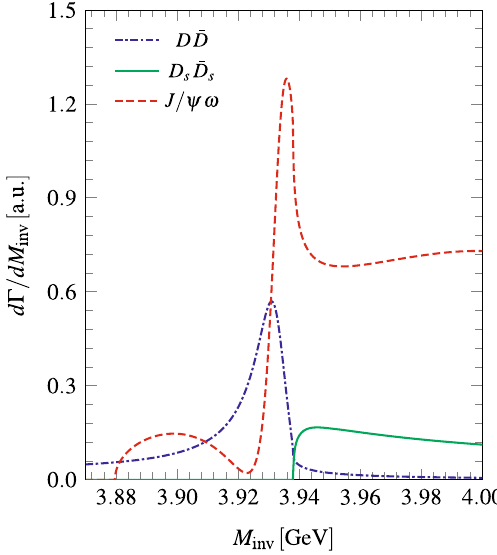
and D ¯ D , D ¯ D tionofthe J /ψω massdistribution,denotedas of the weights C , C (cid:6) , C (cid:6)(cid:6) appearing in ˜ t J /ψω